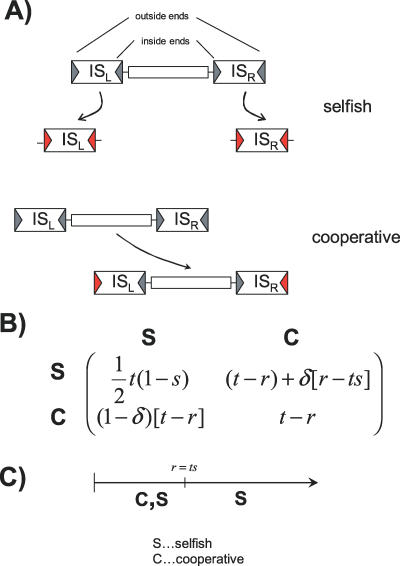
Selfish and Cooperative Transposition, and the Game ISs Play(A) shows the basic structure of a composite transposon. The narrow open bar indicates the selectable gene(s). The wide bar inscribed with ISL and ISR indicates the ISs flanking these genes. Gray triangles indicate the inverted repeats that constitute the inside and outside ends of the ISs. Red triangles indicate repeat sequences used in a particular type of transposition event. The upper panel illustrates selfish transposition, where either IS transposes independently from the other. The lower panel illustrates cooperative transposition, where the composite transposes as a whole, taking the selectable genes with it.(B) The structure of the payoff matrix P describing the payoff to ISL in the symmetric game, where both ISs have the same target specificity and the same likelihood of undergoing DNA rearrangement. The parameter t is the joint probability of transposition and horizontal transfer of the transposition product, r is the probability of DNA rearrangement associated with cooperative transposition, and s is the probability that the new host of a transposable element will need the selectable genes for its survival. Entry PSC is the payoff to ISL if a selfish ISL is paired with a cooperative ISR in a composite, and analogously for the other entries of P. The payoff matrix for ISR is the transpose of P.(C) Schematic diagram of the evolutionary stable strategies (ESSs) in the case of genetic dominance of selfish transposition. Selfish transposition (“S”) is the only ESS if r > ts. Selfish and cooperative transposition (“C”) are both ESSs if r < ts.